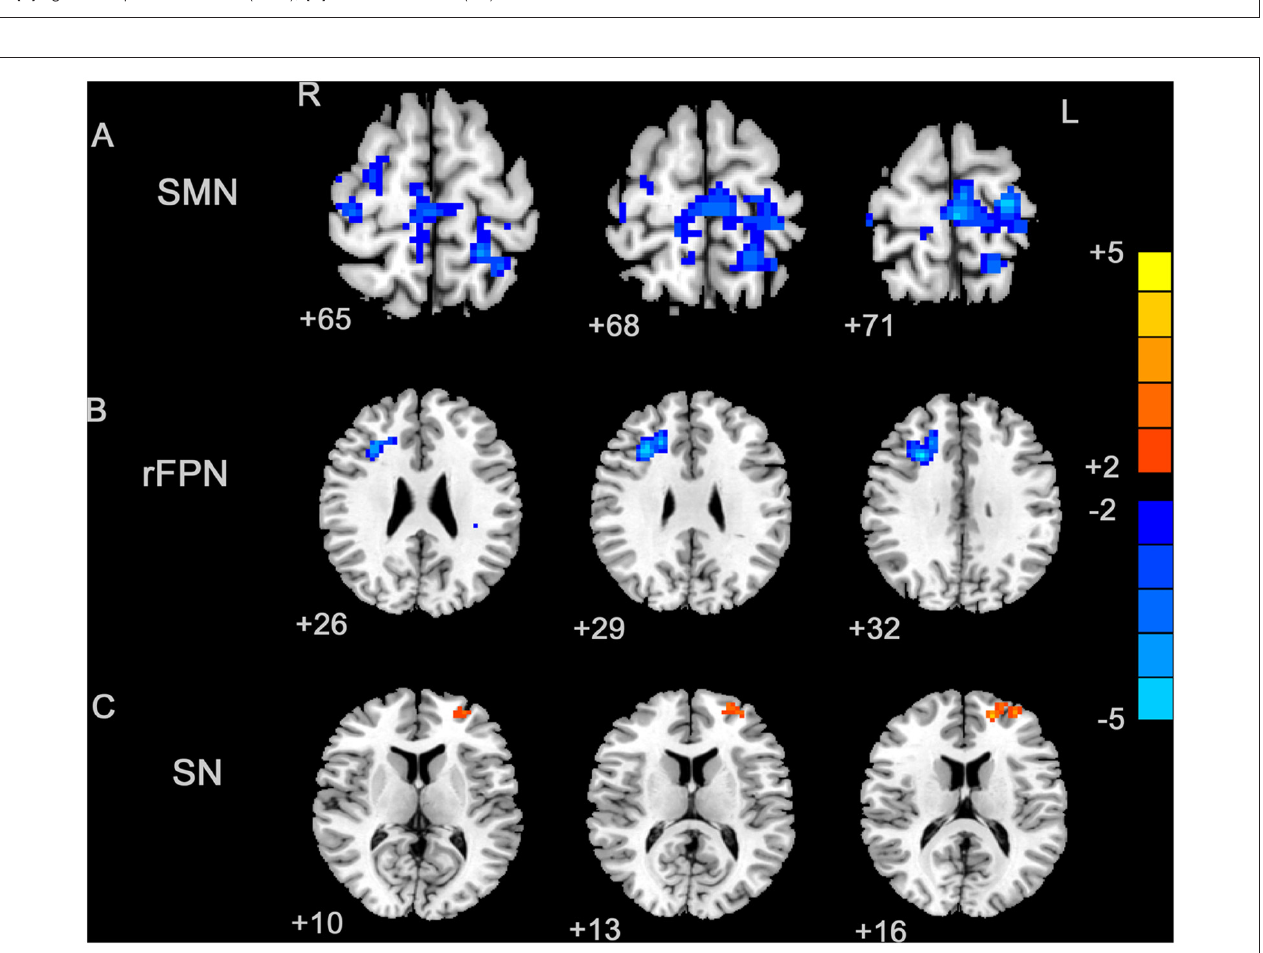
FIGURE 2 | Between-group effects in the SMN, rFPN and primary visual network (PVN). The between-group effects for three networks are shown. The between-group effects were AlphaSim corrected ( p < 0.05). (A) Precentral regions, postcentral regions, frontal regions, supplementary motor area (SMA), precuneus and parietal regions that were abnormally connected within the SMN, indicating decreased connectivity within the blepharospasm (BPS) group. (B) The brain regions linked to the rFPN and exhibiting decreased connectivity in the BPS group. (C) The SN exhibited a BPS-related increase in the connectivity of several regions, including the left superior frontal area, middle frontal area (including dorsolateral prefrontal cortex (DLPFC)).